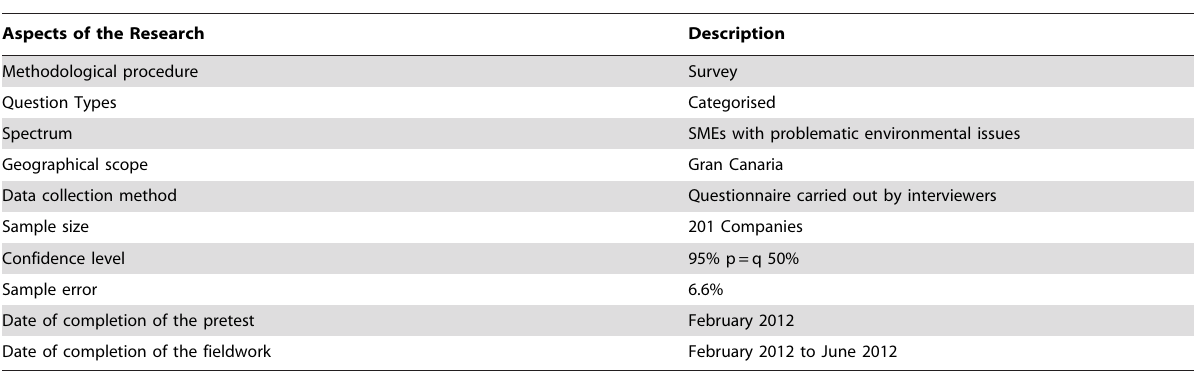
Table 1. Research